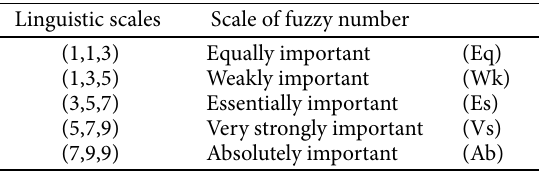
Table 1. Linguistic scale for weight matrix (Hsieh et al. 2004) Linguistic scales Scale of fuzzy number Equally important Weakly